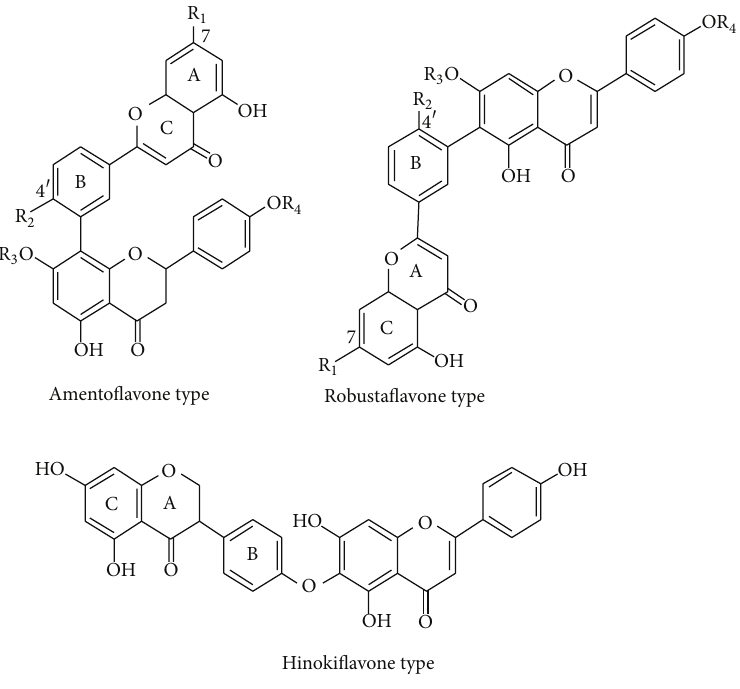
Figure 1: Chemical structures of bioflavonoids in Selaginella doederleinii